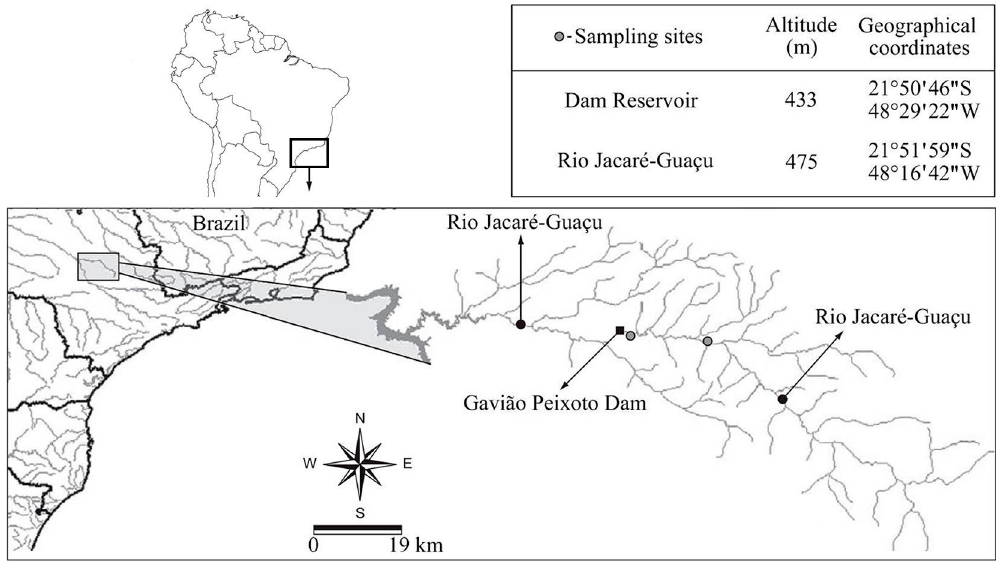
Figure 1. Location of the Rio Jacaré-Guaçu basin in Brazil, South America, with the studied stretch in detail.